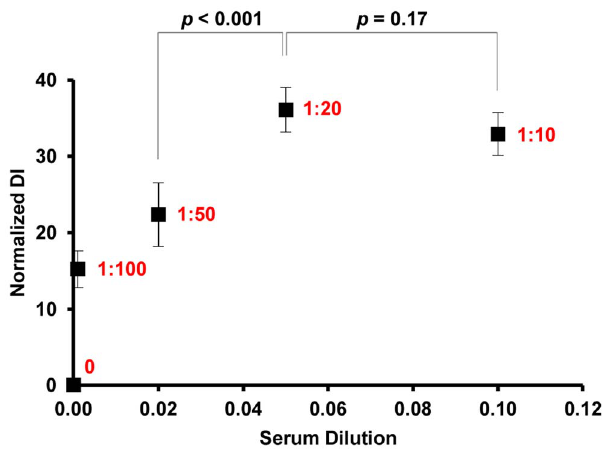
Figure 2. Serum dilution optimization. A series of different dilutions of Strongyloides positive serum were analyzed to determine the optimal serum concentration for use in dot-serology assays. Dilutions of 1:10 and 1:20 generated the highest antibody signal with no differences between the two dilutions ( p =0.17), while a significant decrease in signal intensity was observed between 1:20 and 1:50 dilutions ( p , 0.001). A serum dilution of 1:20 was determined to be optimal for the dot-based Strongyloides assay. Data represent mean 6